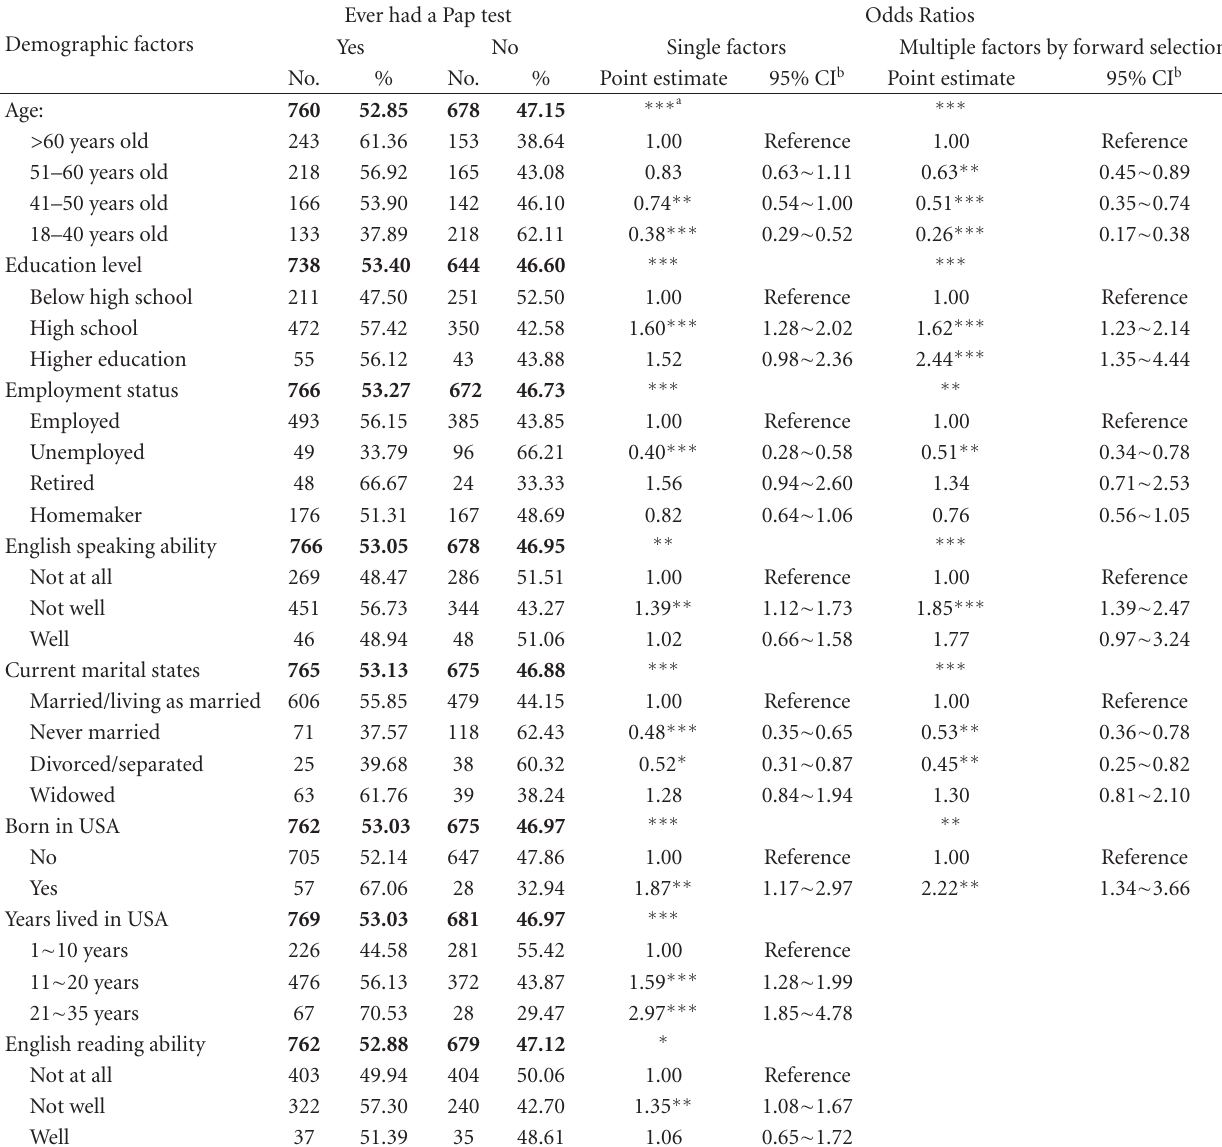
Table 1: Associations between demographic characteristics and Papanicolaou (PAP) testing among Vietnamese